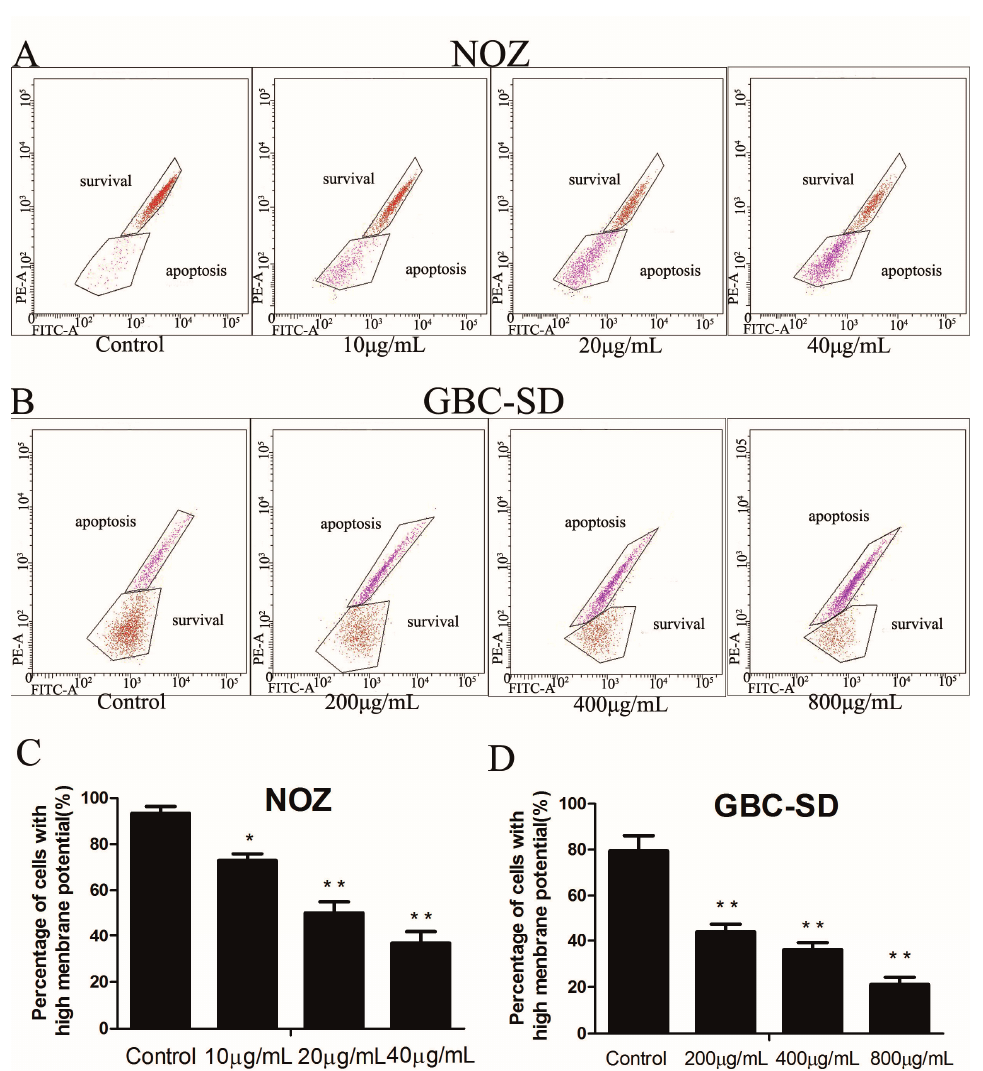
Figure 5. Cordycepin reduces ΔΨ m in human gallbladder cancer